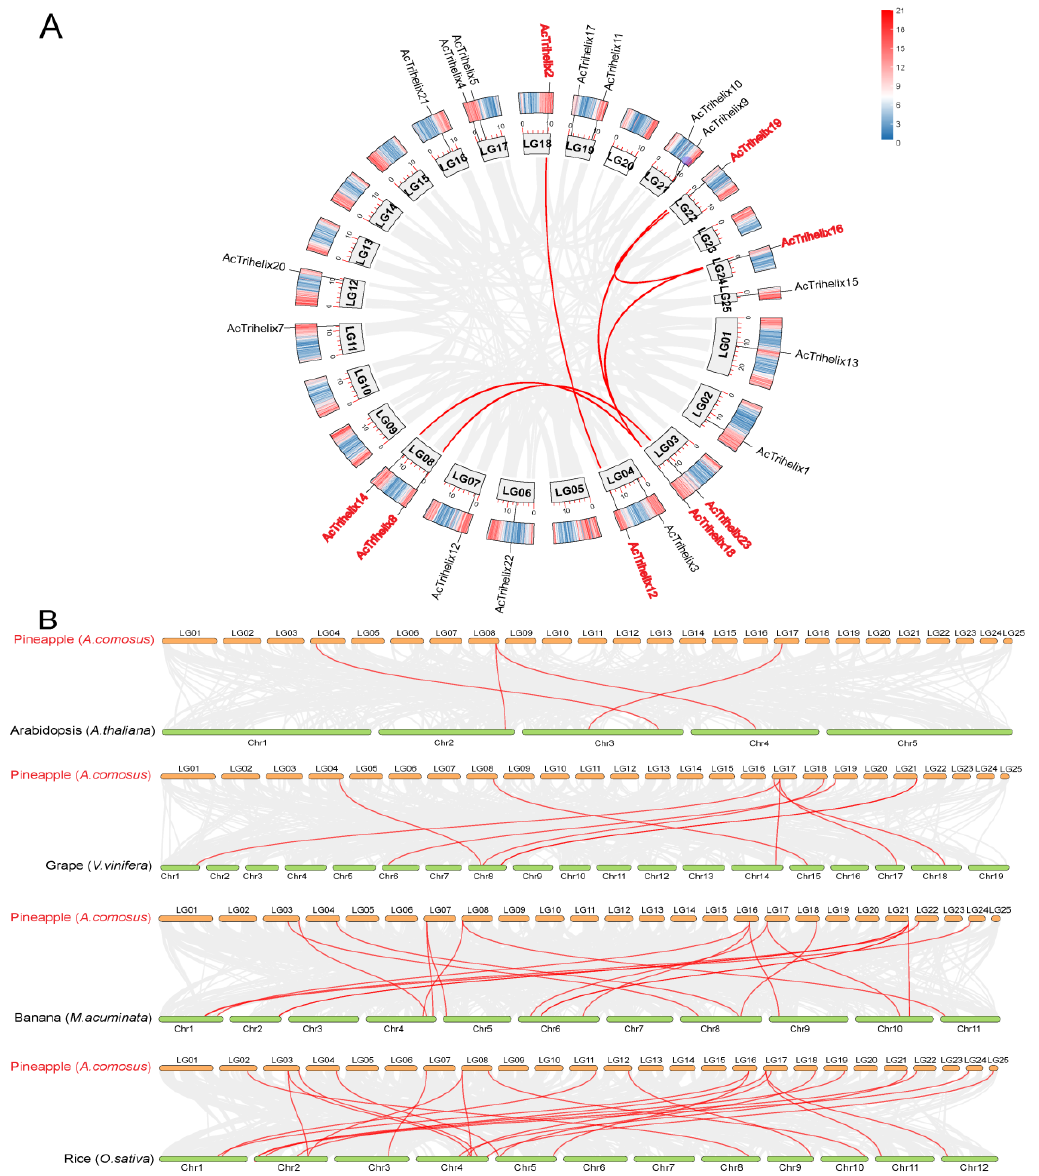
Figure 5. Duplication analysis and synlinearity analysis: ( A ) duplicate analysis of AcTrihelix gene in pineapple; ( B ) synteny analysis of AcTrihelix gene between pineapple and other plants ( Arabidopsis and grape, rice and banana). The red line represents the homologous gene pairs.